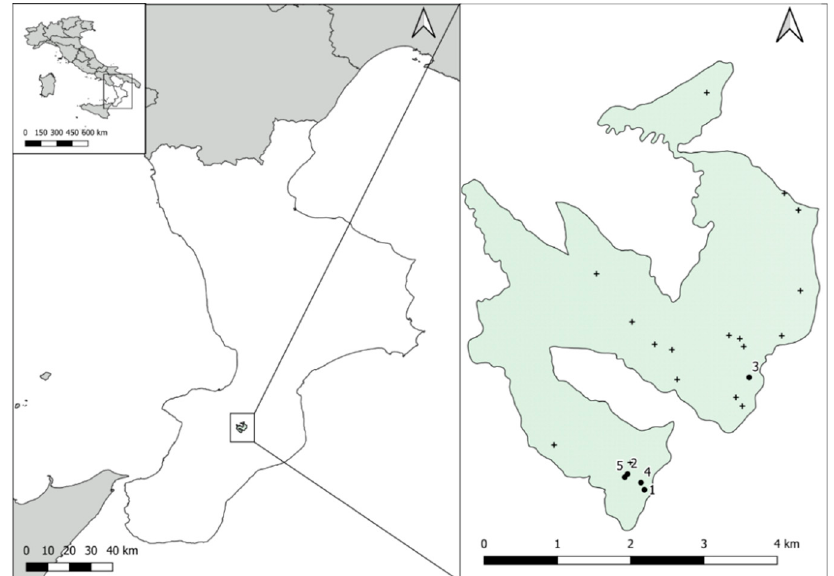
Figure 3. Findings of P. italicus in the Riserva Naturale Biogenetica Marchesale. On the left, position of the reserve in Calabria (Southern Italy). On the right, sampling sites (crosses and dots): the numbers near the dots mark the five sites where adults of P. italicus were found. Maps produced with QGIS software (https://qgis.org, accessed on 3 October 2022). Table 1. Characteristics of the 22 sampling sites in Riserva Naturale Biogenetica Marchesale: site number (Site n.), altitude (m a.s.l.), site quality, number of fallen trunks (FT) and average diameter (cm) ± standard deviation (SD), number of host fallen trunks (HT) and average diameter (cm) ± SD,